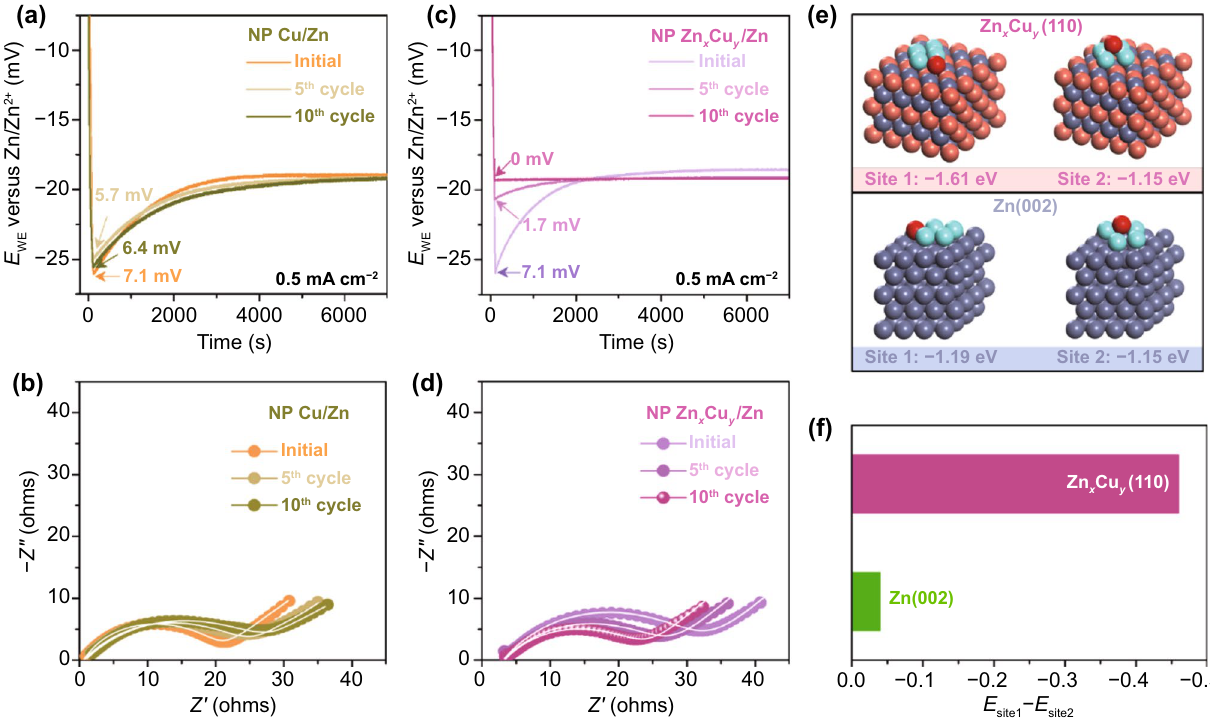
Fig. 2 Effect of surface Zn‑Cu alloying on Zn deposition. a Voltage–time profiles and b EIS spectra of galvanostatic Zn deposition on nanopo‑ rous Cu/Zn electrode at 0.5 mA cm ‒ 2 after Zn stripping/plating for 0, 5 and 10 cycles without the assistance of SDS, where there does not take place alloying of Zn and Cu. c Voltage–time profiles and d EIS spectra of galvanostatic Zn deposition on nanoporous Zn x Cu y /Zn electrode after SDS‑assisted Zn stripping/plating at 0.5 mA cm ‒ 2 for 0, 5 and 10 cycles, which enables the formation of Zn x Cu y alloy shell via an in situ surface alloying of Zn and Cu. The current density of galvanostatic Zn deposition: 0.5 mA cm ‒ 2 . e Zn deposition at side site (site 1) and top site (site 2) on the Zn(002) and Zn x Cu y (110) surfaces with different binding energies. f Comparison of energy difference between site 1 and site 2 at which Zn is deposited on the Zn(002) and Zn x Cu y (110)